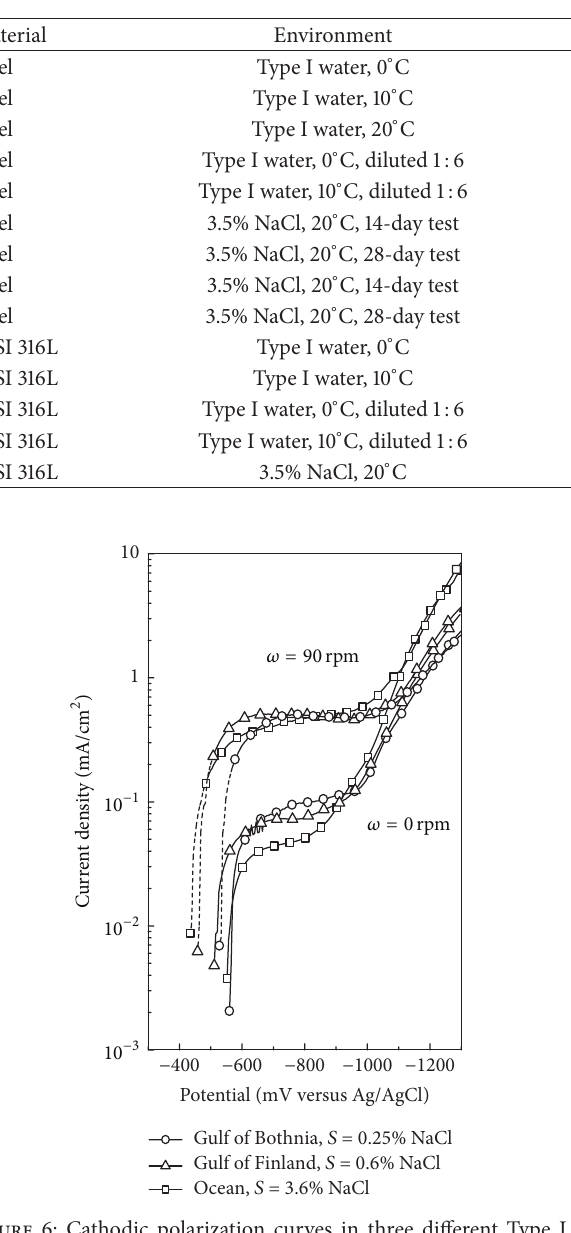
Table 3: Corrosion rates for unalloyed steel and AISI 316L type stainless steel.